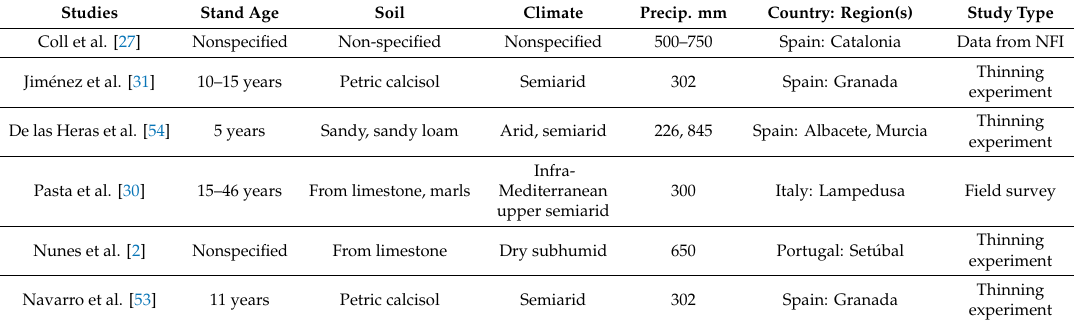
Table 5. List of studies investigating the influence of overstory variables on the understory of P. halepensis stands. The information shown in the table was directly retrieved from the respective papers; NFI—National Forest Inventory. The results of these studies are displayed in Table 6.